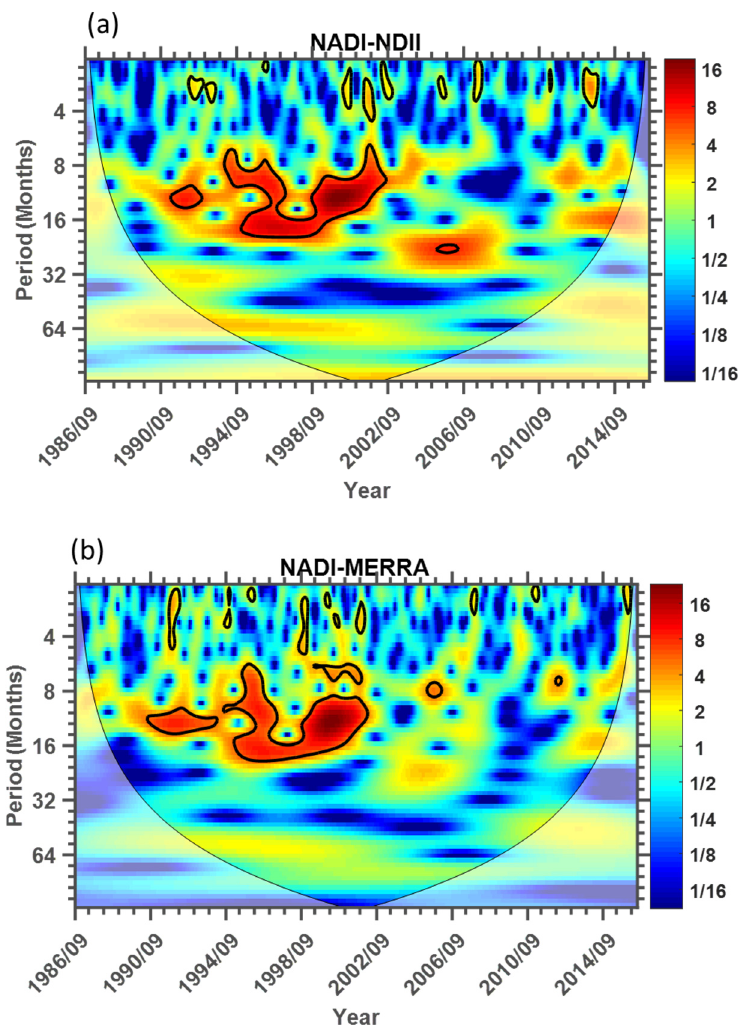
Figure 11. Wavelet transform of ( a ) NADI-NDII and ( b ) NADI-MERRA–2 between 1986 and 2016 in the Luvuvhu River Catchment. The solid black line contour delimits the region (red) where the power is strong and significant, and the cone od influence indicates the 95% confidence interval.